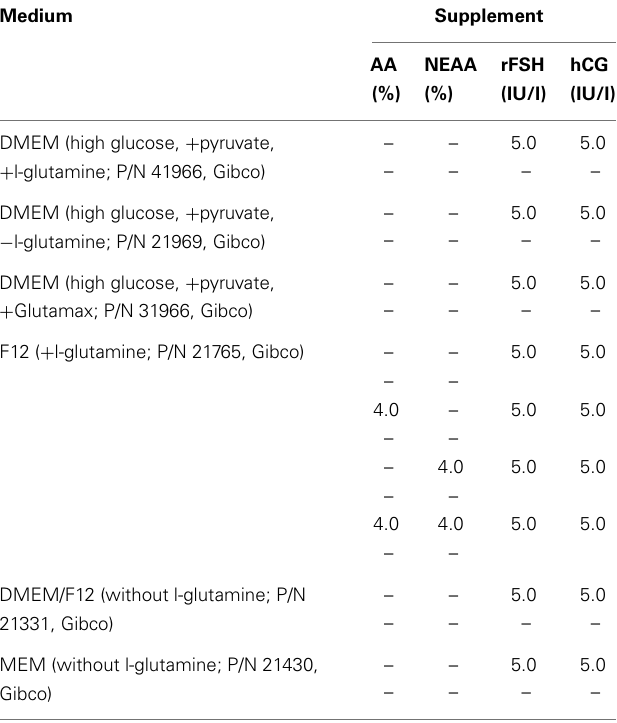
Table 1 | Schematic illustration of the experimental conditions employed to characterize the effects of the culture medium